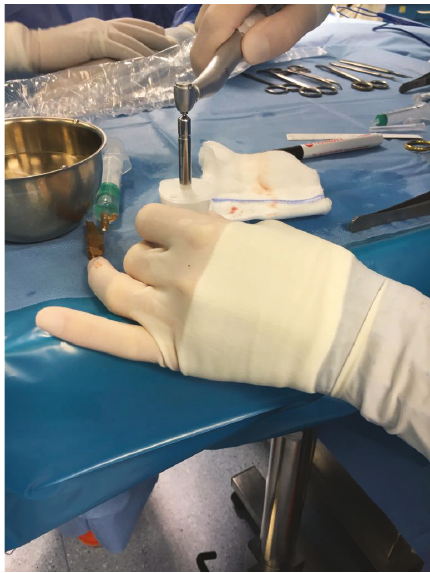
Figure 5: Connection of the disposable Rigeneracons to the Rigenera OR-PRO rotating machine.